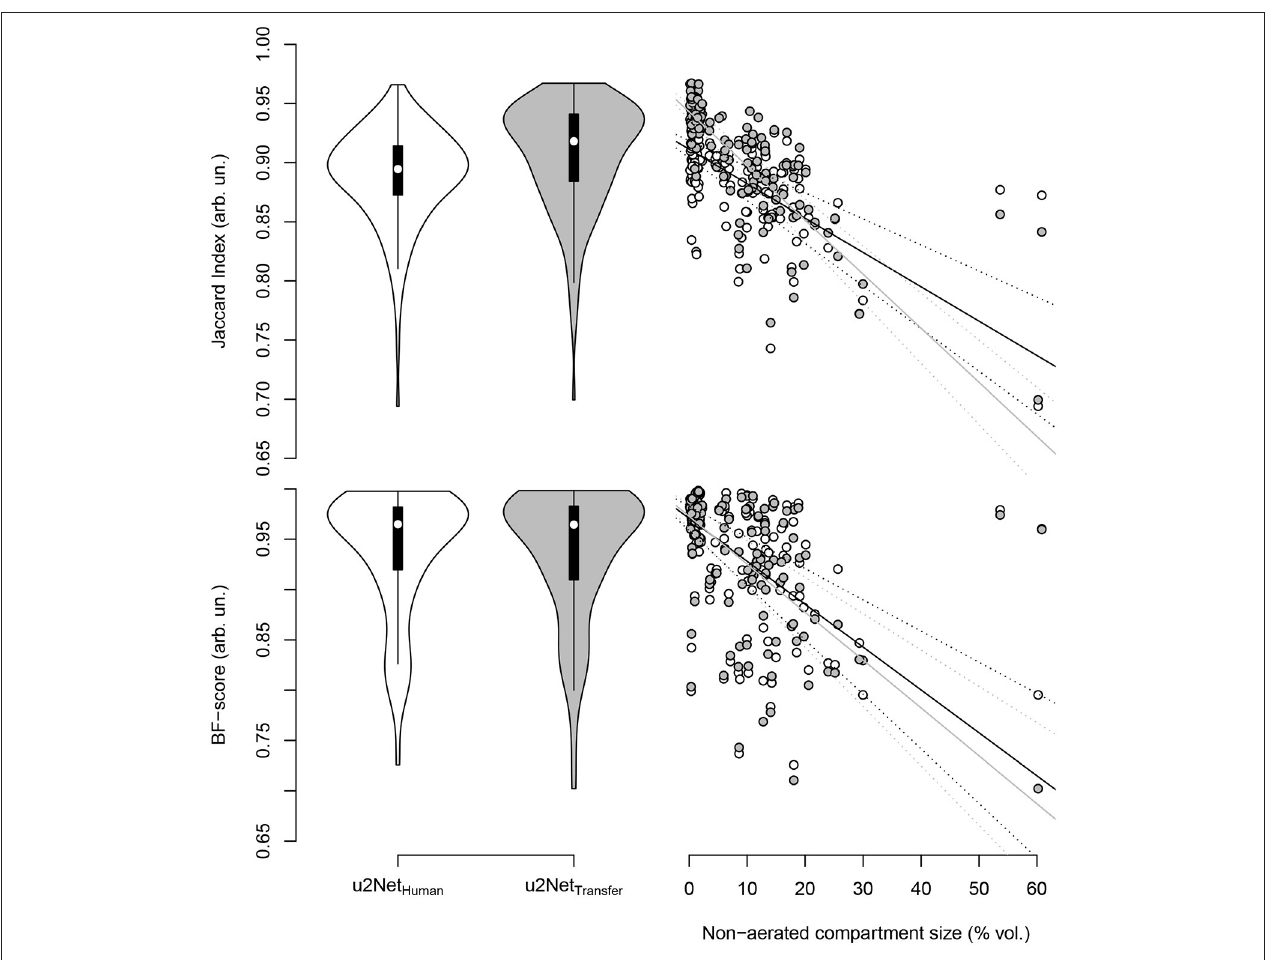
FIGURE 3 | Jaccard index (top) and BF-score (bottom) for networks trained from human data only ( u 2 Net Human , “white”) and through transfer learning of networks trained on animal CT data ( u 2 Net Transfer , “grey.”) In the right column the respective measure over relative size of the non-aerated compartment in % volume and its linear regressions with slopes S JI and S BF , as well as their respective confidence intervals.